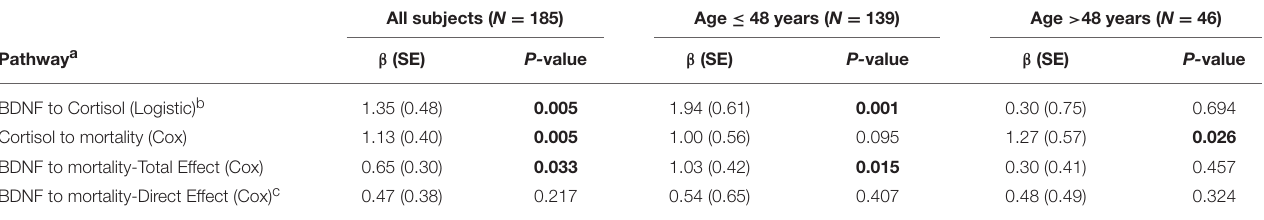
TABLE 2 | Prior knowledge of BDNF and mortality association mediated by cortisol level among all subjects and stratified by 75th quartile of age. All subjects ( N = 185)